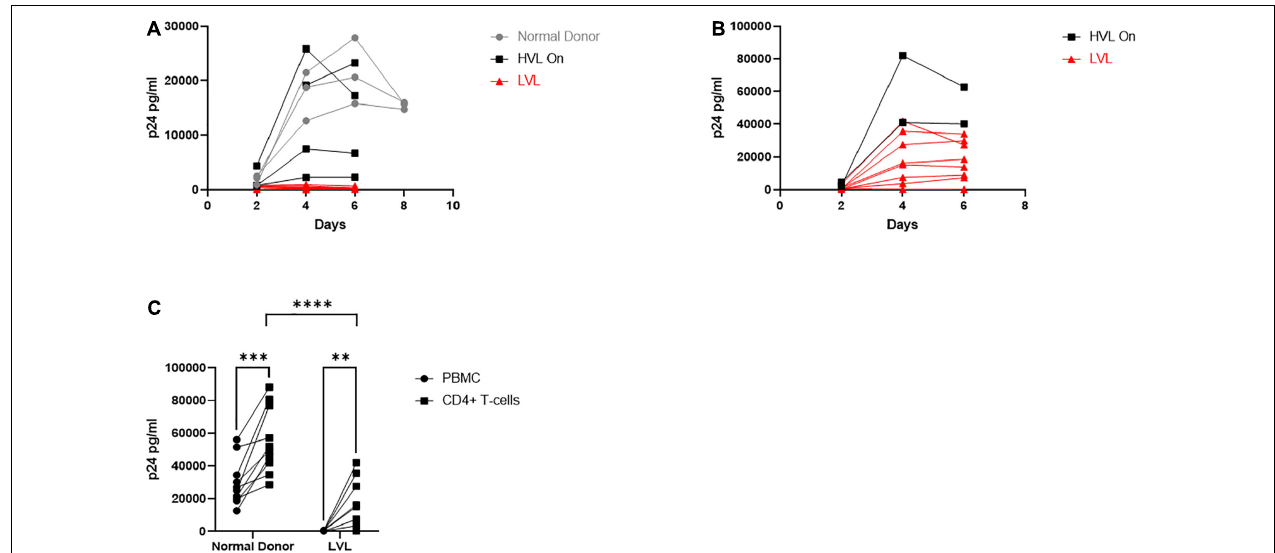
FIGURE 2 | Total PBMCs from low viral load (LVL) donors do not support HIV spreading infection in vitro . (A) Total PBMCs collected from normal donors (gray, n = 3), high viral load donors on ART (HVL, black, n = 4) and ART naïve low viral load donors (LVL, red, n = 8) were induced with PHA and IL-2 then infected with NL4-3 48 h later. Supernatant was collected every 48 h post infection and virus levels were determined by p24 ELISA. (B) CD4 + T-cells were isolated from PBMCs from HVLs (black, n = 2) and LVLs (red, n = 8) by magnetic bead based isolation. Resulting CD4 + T-cells were induced with PHA and IL-2 then infected with NL4-3 48 h later. Supernatant was collected every 48 h post infection and virus levels were determined by p24 ELISA. (C) Measurement of peak p24 production in total PBMCs or isolated CD4 + T-cells from the indicated groups. Two-way ANOVA with Sidak’s multiple comparison test was performed. P -value: ∗∗ < 0.01, ∗∗∗ < 0.001, ∗∗∗∗ < 0.0001.